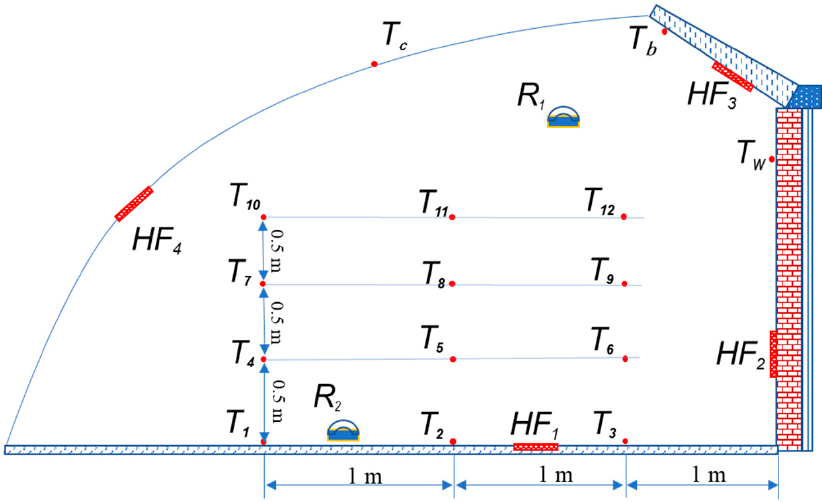
Figure 2. Distribution of sensors located inside the greenhouse for climatic parameters: temperature ( T ), radiation sensor ( R ), and heat flux plate ( HF ).